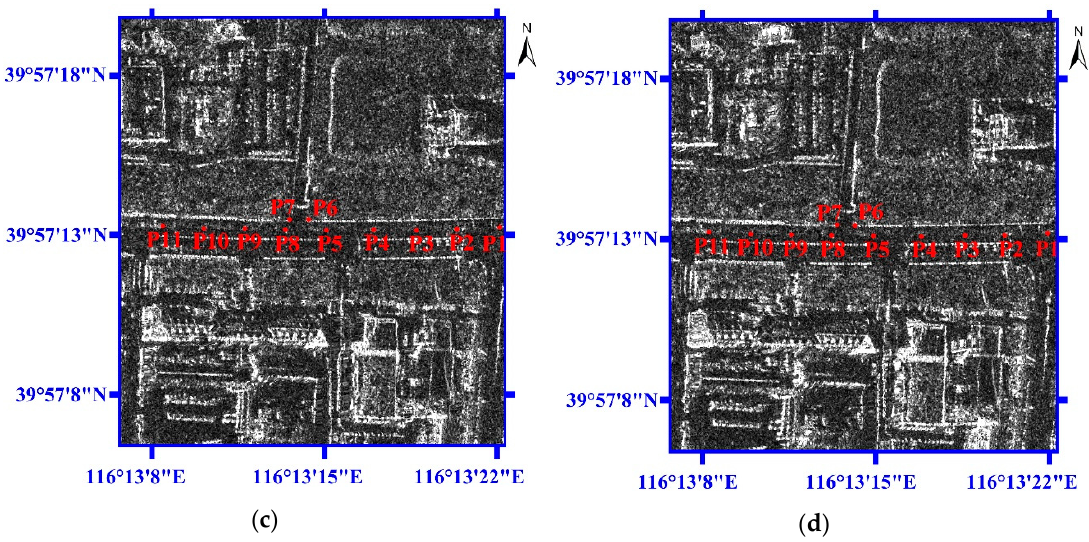
Figure 9. The geolocation results for the street lights and the street barriers located on Xingshikou Road in Beijing. ( a ) The two-dimensional image for M1. ( b ) The two-dimensional image for M2. ( c ) The enlarged image for the red window (Area 2 in Figure 6) in Figure 9a. ( d ) The enlarged image for the red window (Area 2 in Figure 6) in Figure 9b.